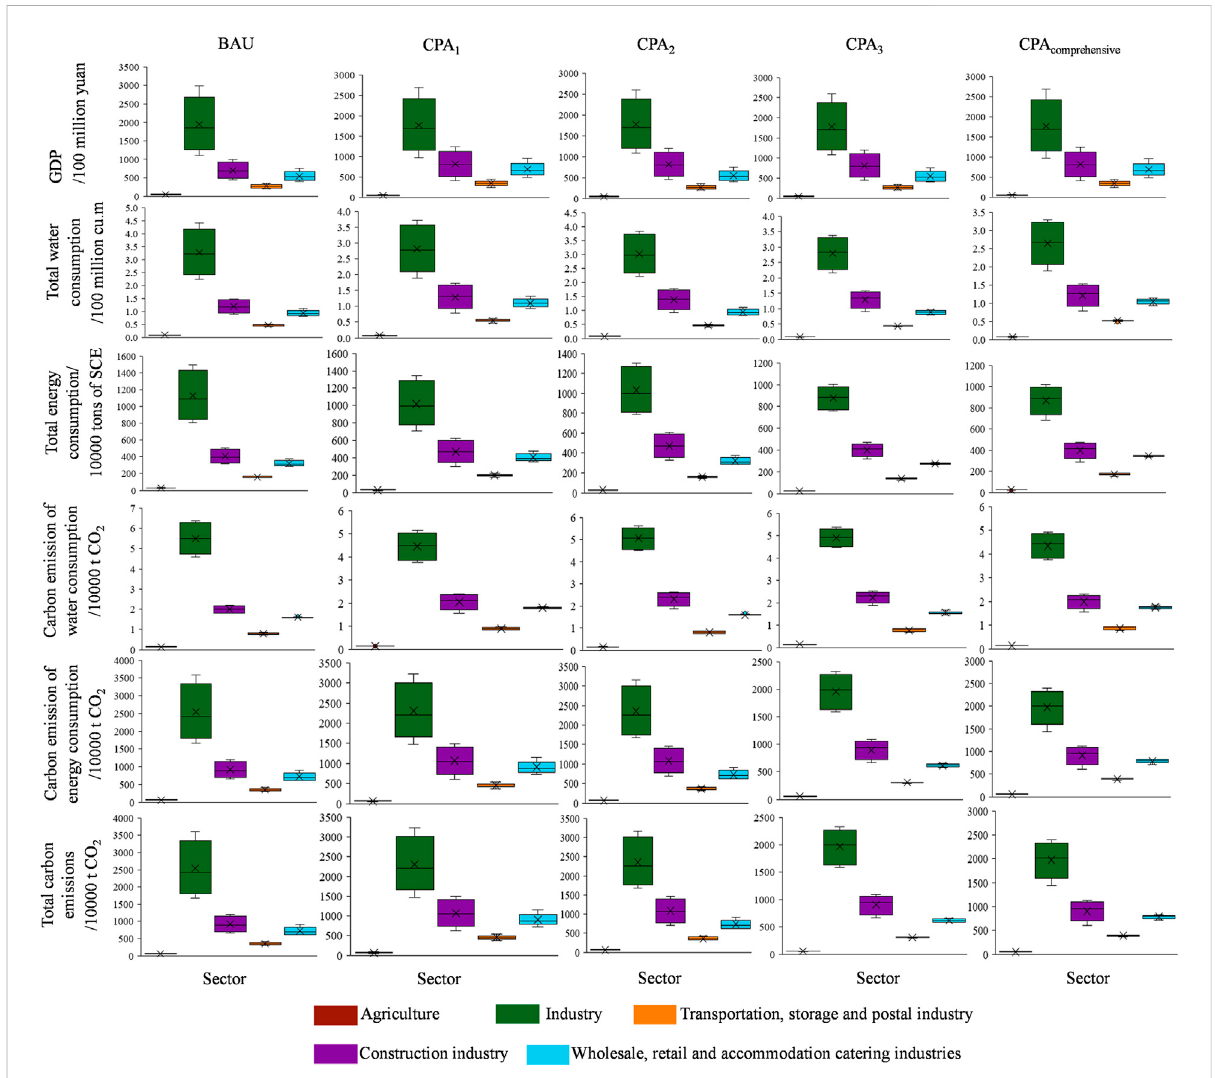
FIGURE 6 Comparison of the simulation results for different industries from 2022 to 2030 (The distance between the median and the upper (lower) quartile of thebox chart is relatively narrow, indicating that thedata within thisdistance is relatively concentrated. The upper (lower) edge of thebox chart is relatively long, indicating that the data covers a wide range on the X axis. The range outside the upper and lower edges indicates abnormal values. Here, take GDP as an example. Speci fi cally, the lower edge of the box in the fi gure represents the 25th percentile of all GDP values arranged from small to large; The top edge of thebox in the fi gure represents the 75th percentile of all GDP values arranged from small to large; The middle horizontal line of the box represents the median of all GDP values, and the upper and lower exposed parts represent the minimum and maximum of all GDP values, so as to visually compare the average, minimum, maximum and abnormal GDP levels of various